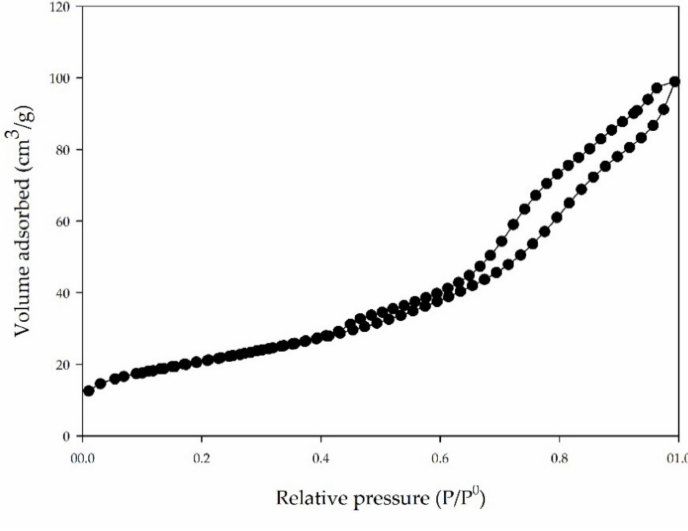
Figure 3. Nitrogen sorption isotherm of mesoporous Pd / Al 2 O 3